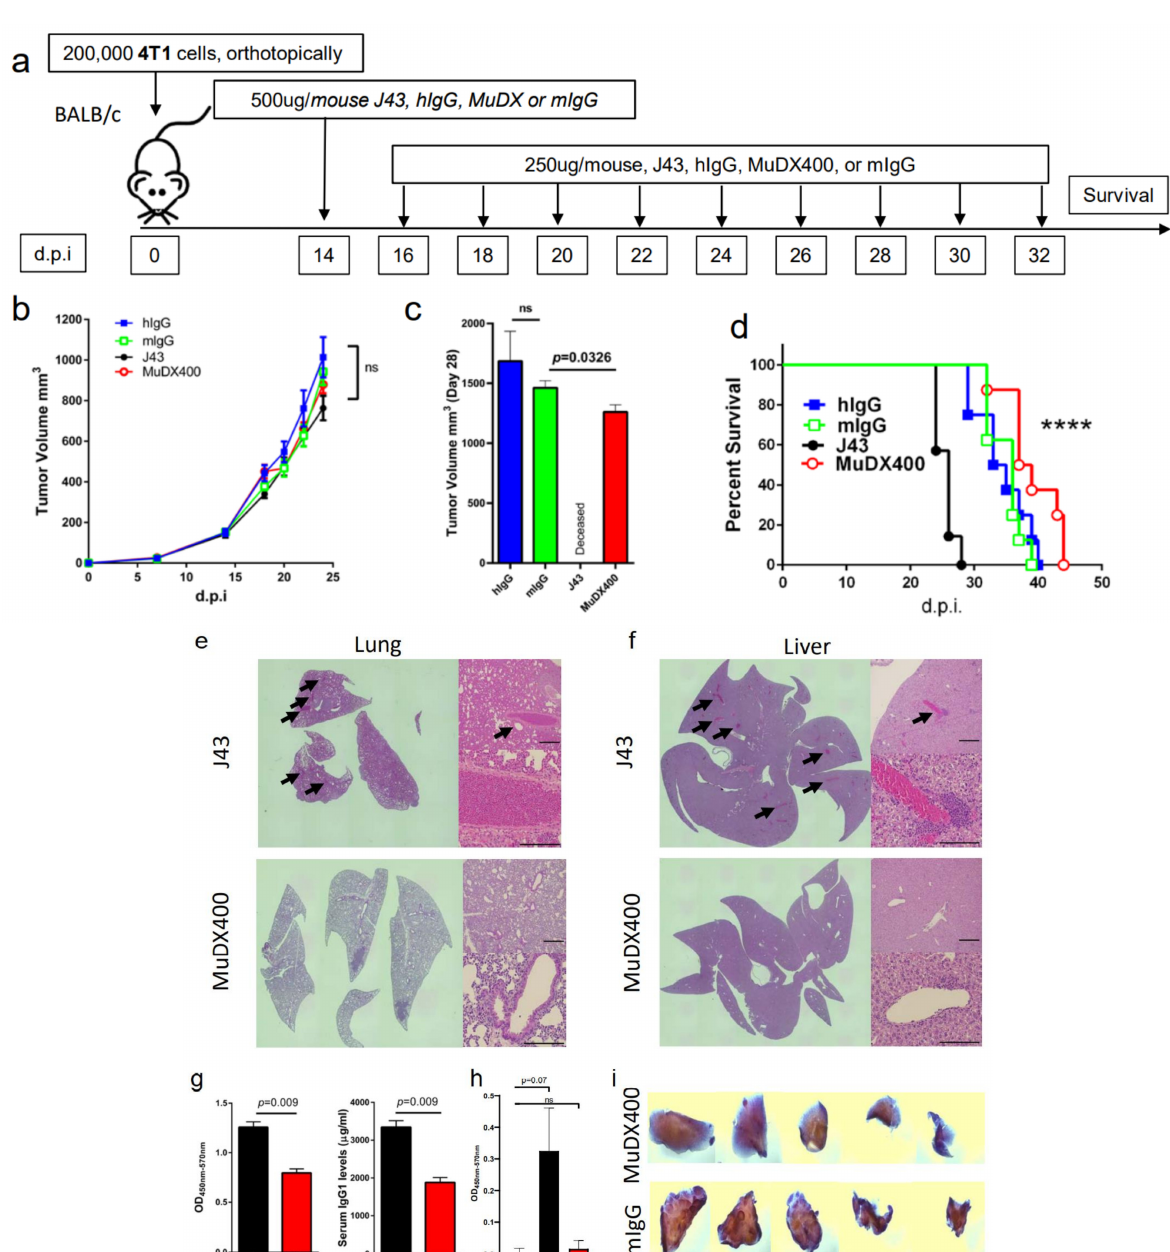
Figure 2. Murine α PD-1 avoided the fatal hypersensitivity associated with xenogeneic reagent in 4T1 breast cancer model. ( a ) Schema showing BALB/c mice were inoculated with 4T1 breast carcinoma cells orthotopically in the breast mammal pad and followed by monotherapy with either mouse α PD-1 (MuDX400) or J43. ( b ) Tumor growth curves of 4T1 in BALB/c mice. Tumor volumes depicted as mean ± s.e.m. ( c ) Tumor volume of 4T1 in BALB/c mice at day 28. Tumor volumes depicted as mean ± s.e.m. ( d ) Kaplan–Meier survival curves of 4T1-tumor-bearing BALB/c mice treated with either MuDX400 or J43. Log-rank (Mantel–Cox) test used to compare groups. Representative H&E stains of ( e ) lungs and ( f ) liver of 4T1 mice treated with either J43 or MuDX400 demonstrating inflammation, loss of normal tissue architecture, and influx of mononuclear cells (black arrows). ( g ) Total serum IgG1 levels evaluated via ELISA of 4T1 tumor bearing mice treated with J43 or MuDX400. ( h ) J43 reactive IgG levels in the serum of 4T1 tumor-bearing mice treated. ( i ) Representative staining of whole-mount lung to examine metastases in 4T1 mice treated with either MuDX400 or mIgG1. Bar graphs represent the mean value and error bars represent the standard error of the mean. **** p < 0.0001, n = 7 to 12 mice per